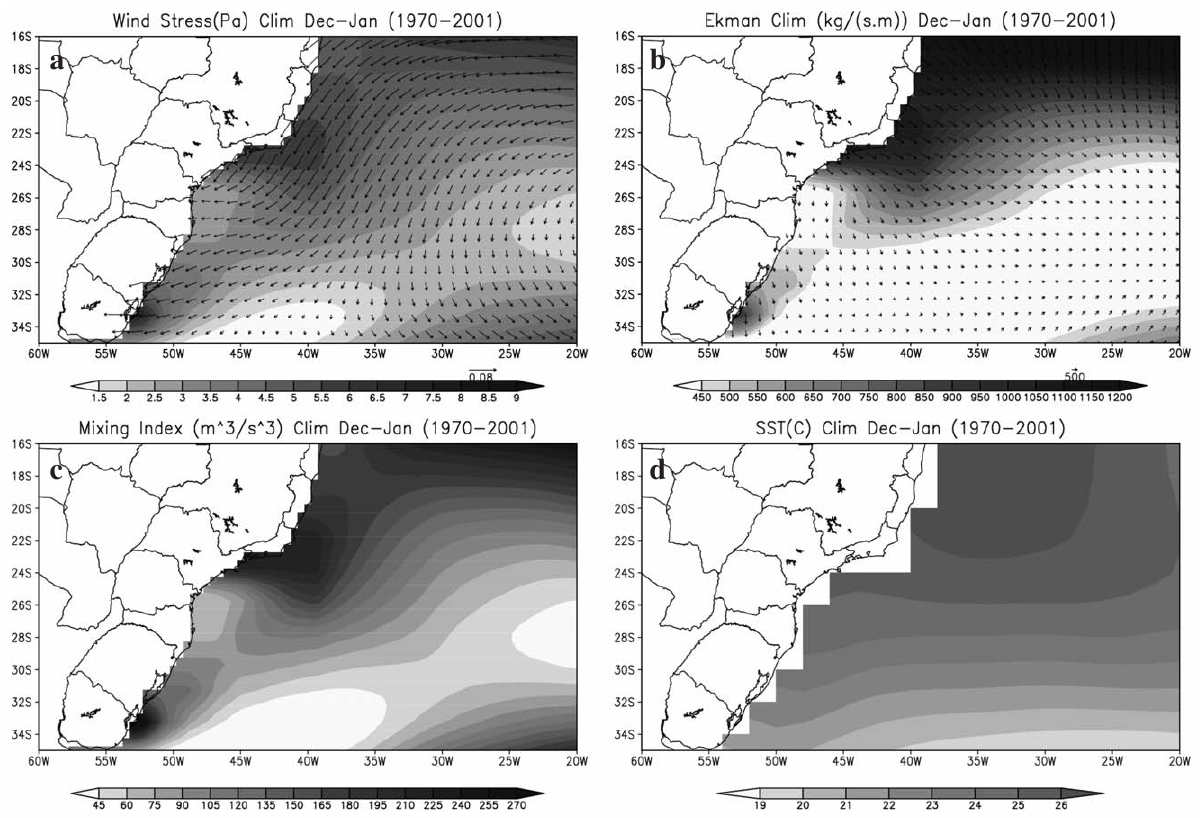
Fig . 3. – Climatology fields of: a) wind stress (Pa), vectors indicate direction (x 10 2 ); b) Ekman transport (kg s -1 m -1 ), vectors indicate direc- tion; c) mixing index (m 3 s -3 ); d) sea surface temperature (°C).